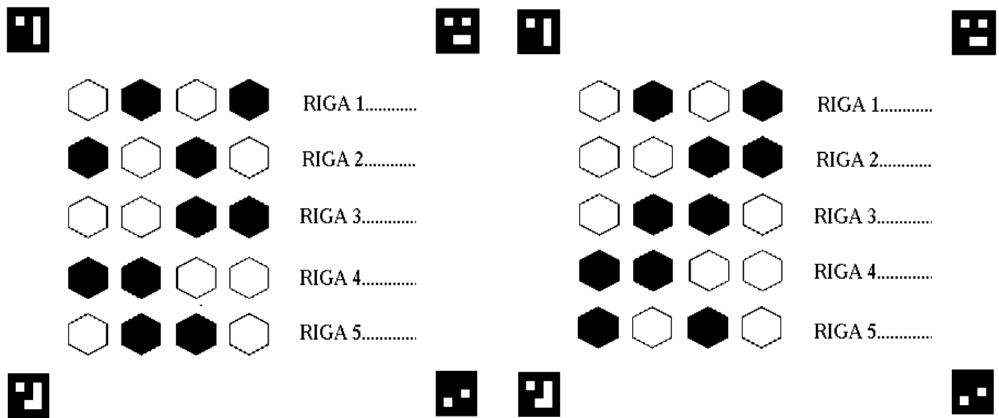
Figure 3. Single-task model ( left ); dual-task model ( right ). The black and white small pictures that surround both models are eye-tracker markers.